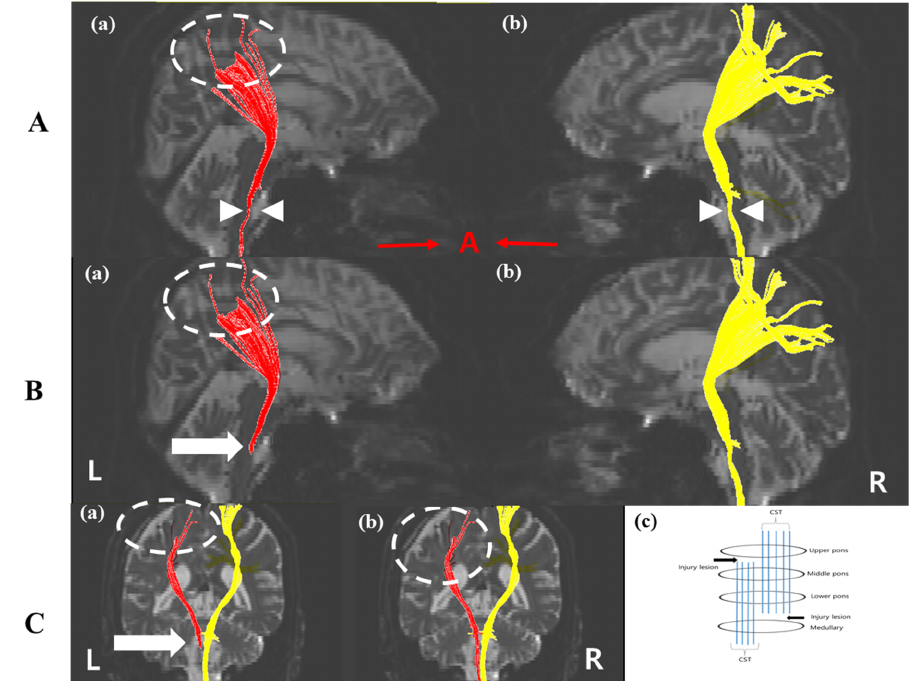
Figure 2. Diffusion Tensor Tractography images four weeks after onset. ( A ) Tract 1 which used ROIs on the lower pons and middle pons showed that (a) the left CST was thinner than the right CST (white arrow head) and (b) discontinuation in the cerebral cortex in the left CST appeared (white dashed circle). ( B ) Tract 2 using ROIs on the lower pons and upper pons indicated the thinner left CST (a) compared with than the right CST (b) did not reach the cerebral cortex (white dashed circle) and the disconnection below the lower pons is shown (white arrow). ( C ) The disruption of the left CST around the EDH location (dashed circle) (a, b) and the dissociation of the left CST below the lower pons (white arrow). (c) Injury lesions analyzed by DTT results. Injury lesions were below the lower pons and between upper and lower pons. CST: corticospinal tract, EDH: epidural hematoma, ROI: region of interest, DTT: diffusion tensor tractography.